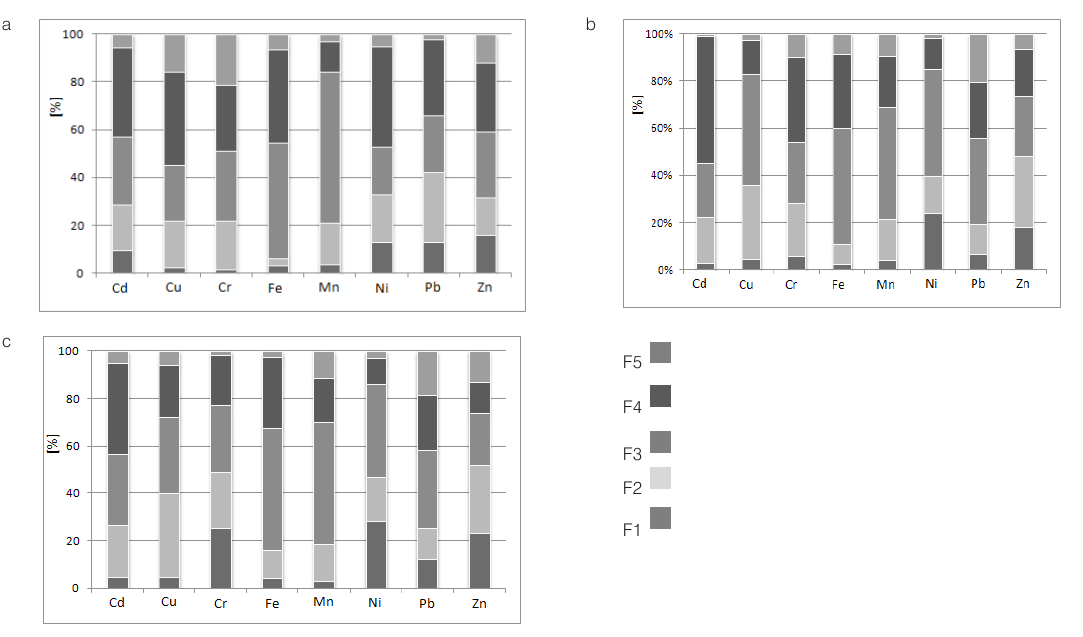
Figure 5. Percentage of analysed metals forms in particular fractions of the Bobrza River in sampling Points 1 (a), 2 (b) and 3 (c) of collecting water